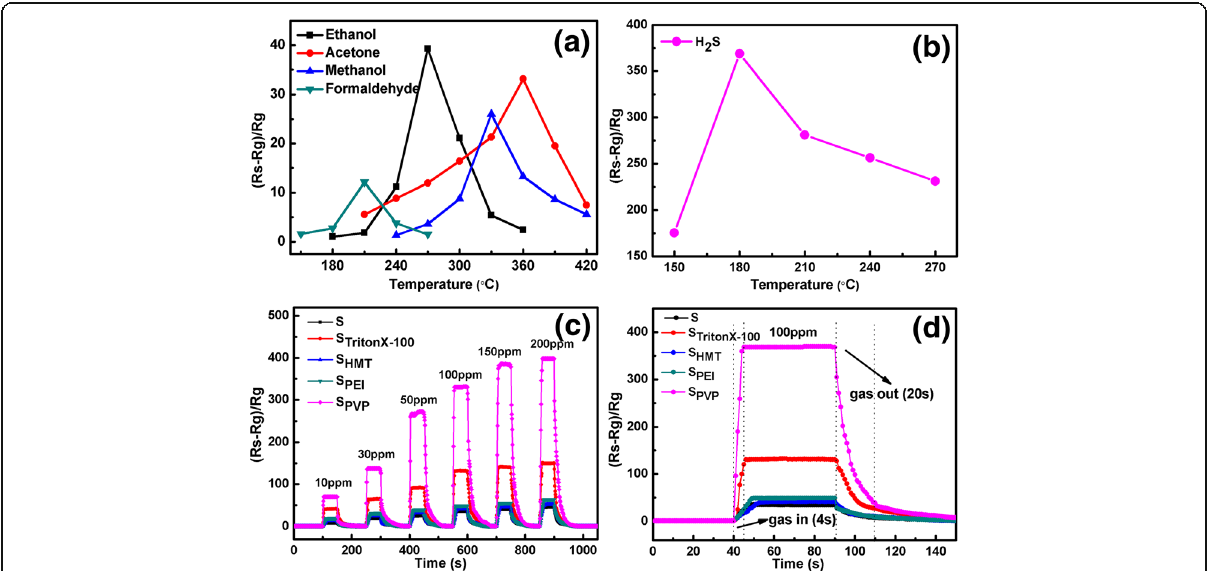
Fig. 7 a Response of S PVP sensor to 100 ppm ethanol, acetone, methanol, and formaldehyde at different operating temperatures. b Response of S PVP sensor to 100 ppm H 2 S at different operating temperatures. c Response versus time curves of the sensors to 10 – 200 ppm H 2 S consecutively at180 °C. d Dynamic sensing transient of the sensors to 100 ppm H 2 S at 180 °C